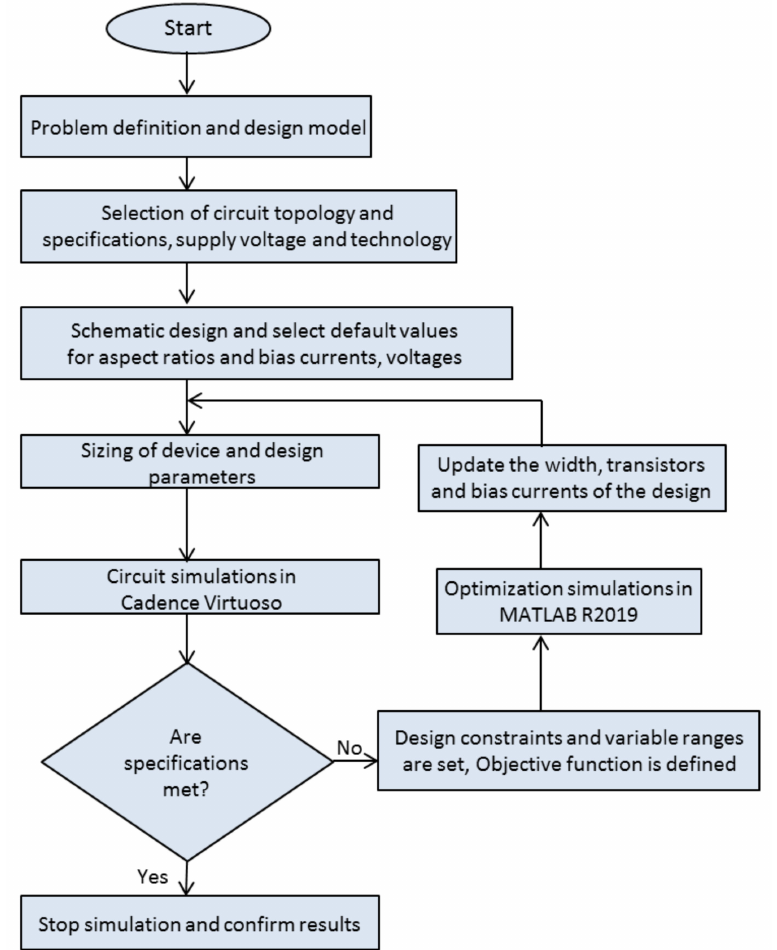
Figure 2. Process flow for the metaheuristics considering circuit